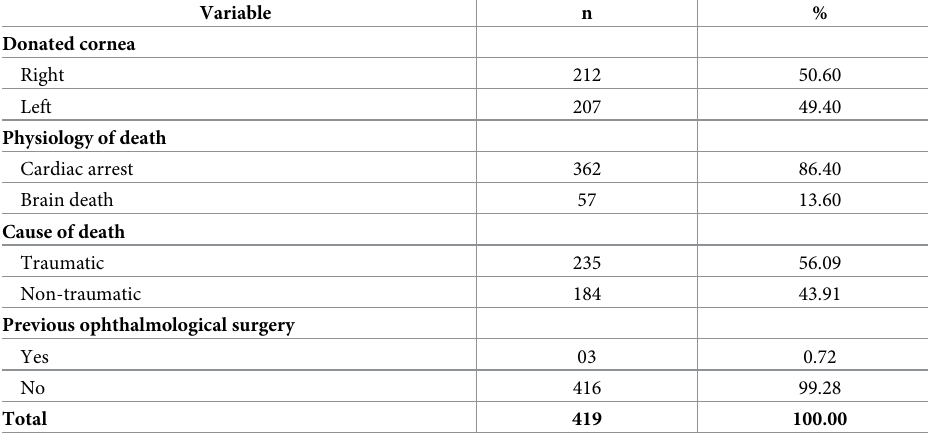
Table 1. Clinical profile of the cornea donors. Brazil, 2020 (n = 419).